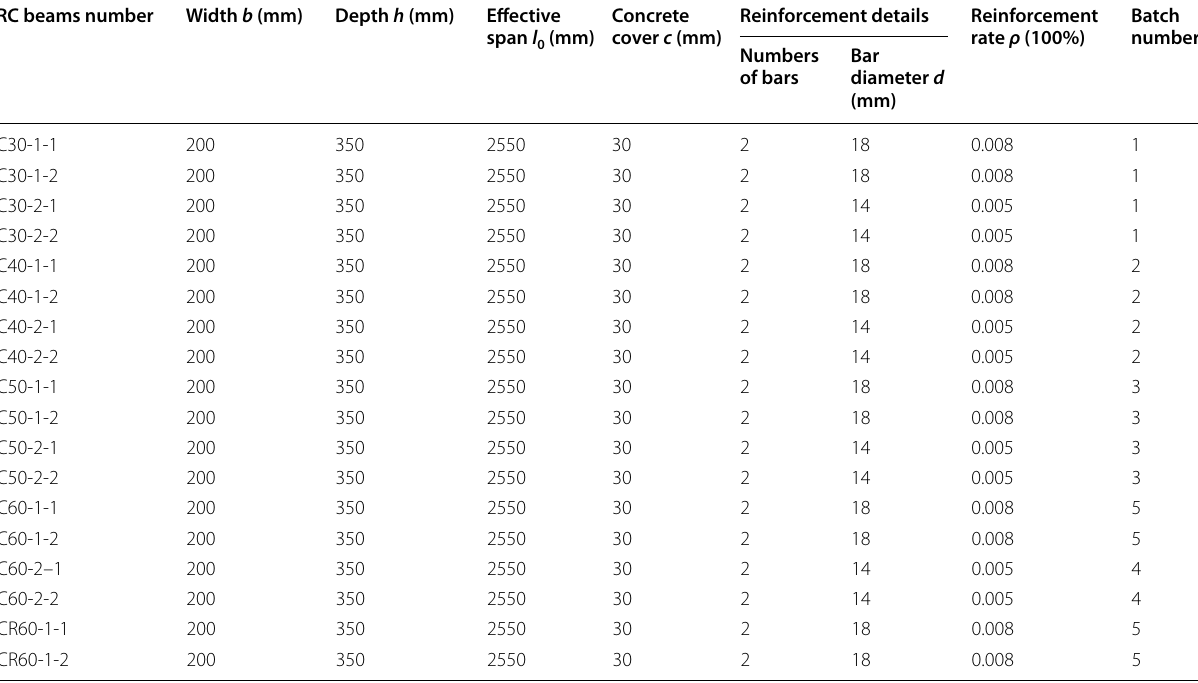
Table 5 Details of RC